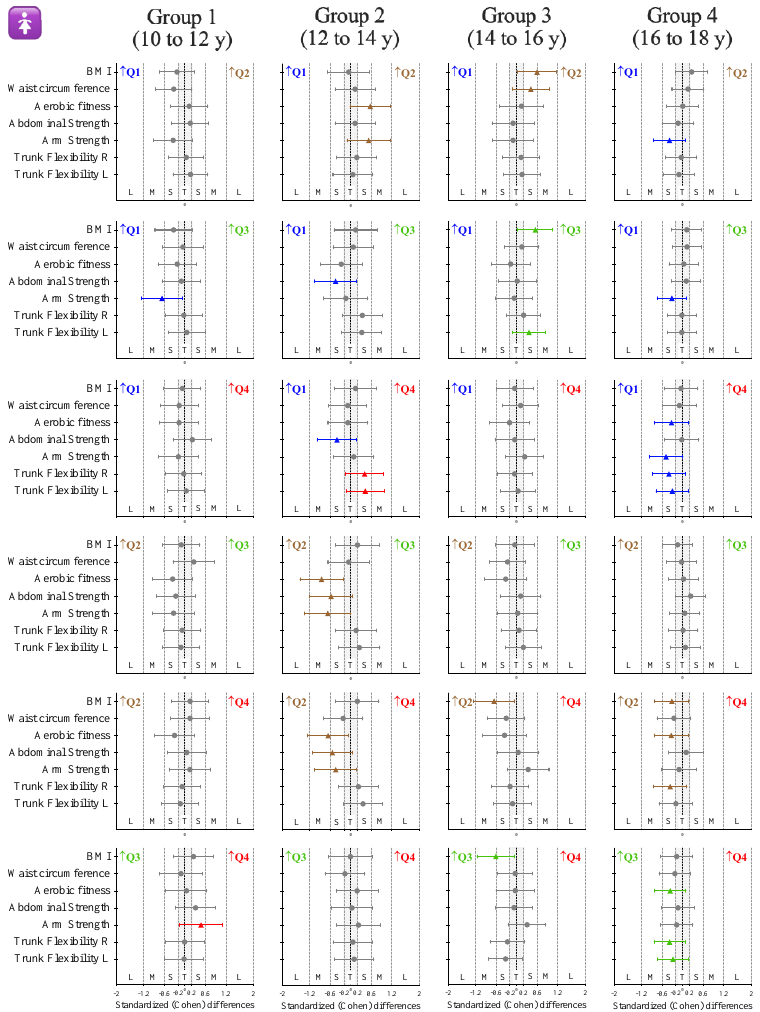
Figure 1. Standardized (Cohen) differences in the considered variables according to the age group for female participants. Error bars indicate uncertainty in the true mean changes with 95% confi- dence intervals. Abbreviations: Q1 = first quarter, participants born in January, February and March; Q2 = second quarter, participants born in April, May and June; Q3 = third quarter, participants born in July, August and September; Q4 = fourth quarter, participants born in October, November and December. ↑ = means that the participants from that quarter presented higher values. Gray error bars denote unclear results.